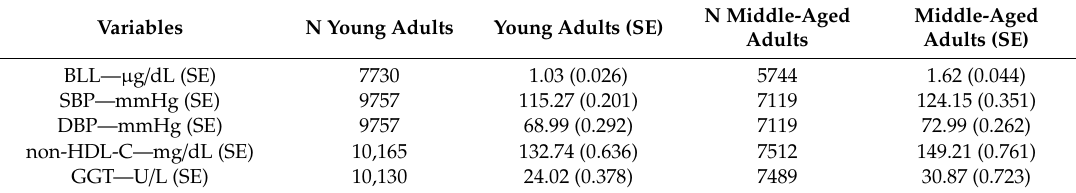
Table 1. Variables of interest among categories of